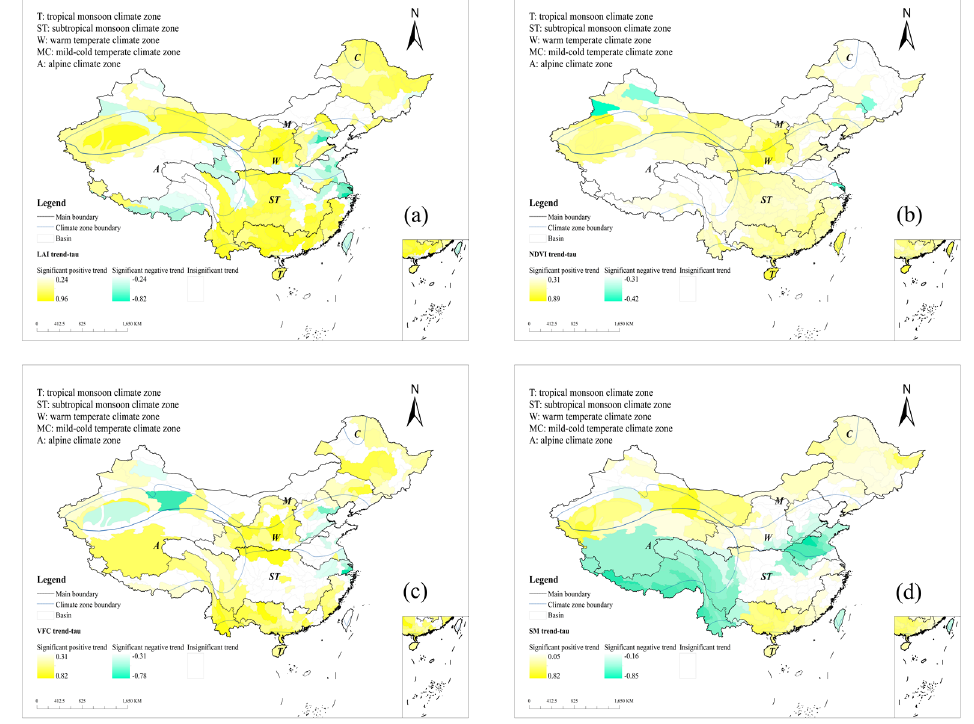
Figure A3. The spatial distributions of significant temporal trends ( p < 0.05) of ( a ) P ; ( b ) PE ; ( c ) ET ; and ( d ) T ave .